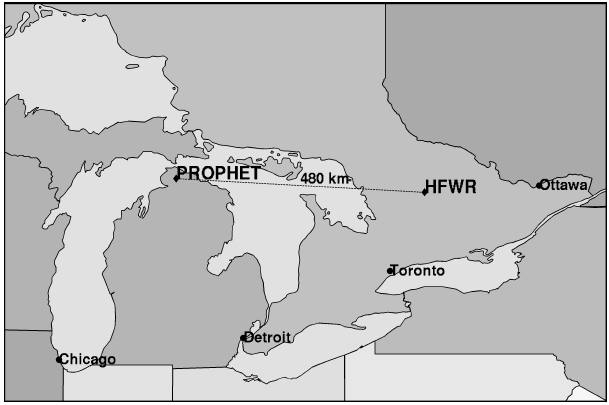
Fig. 1. Locations of PROPHET and HFWR